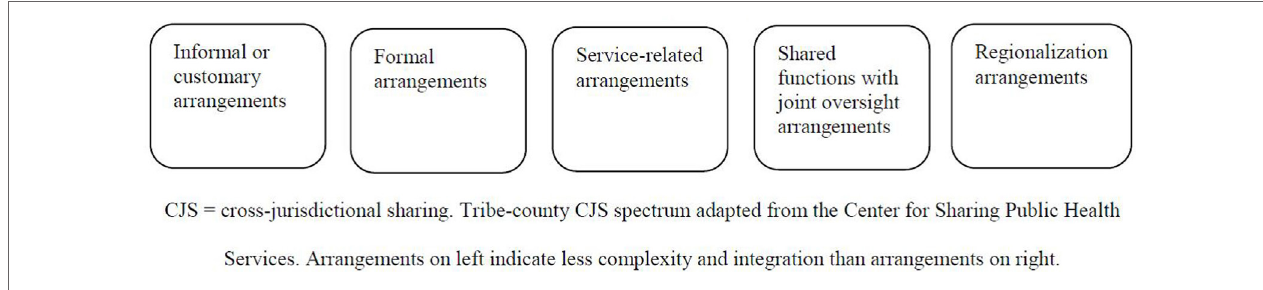
FigUre 1 | Tribe–county CJS spectrum. CJS, cross-jurisdictional sharing. Tribe–county CJS spectrum adapted from the Center for Sharing Public Health Services. Arrangements on left indicate less complexity and integration than arrangements on